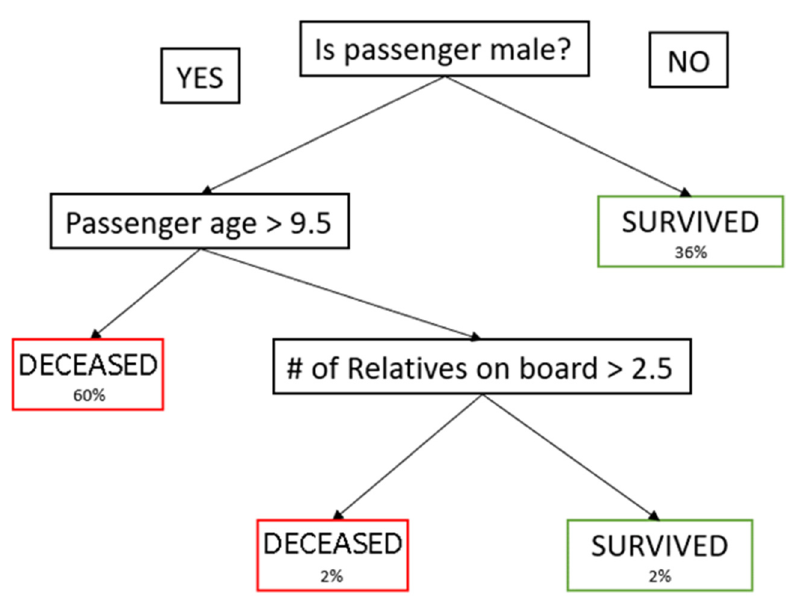
Figure 4. Example of a decision tree.